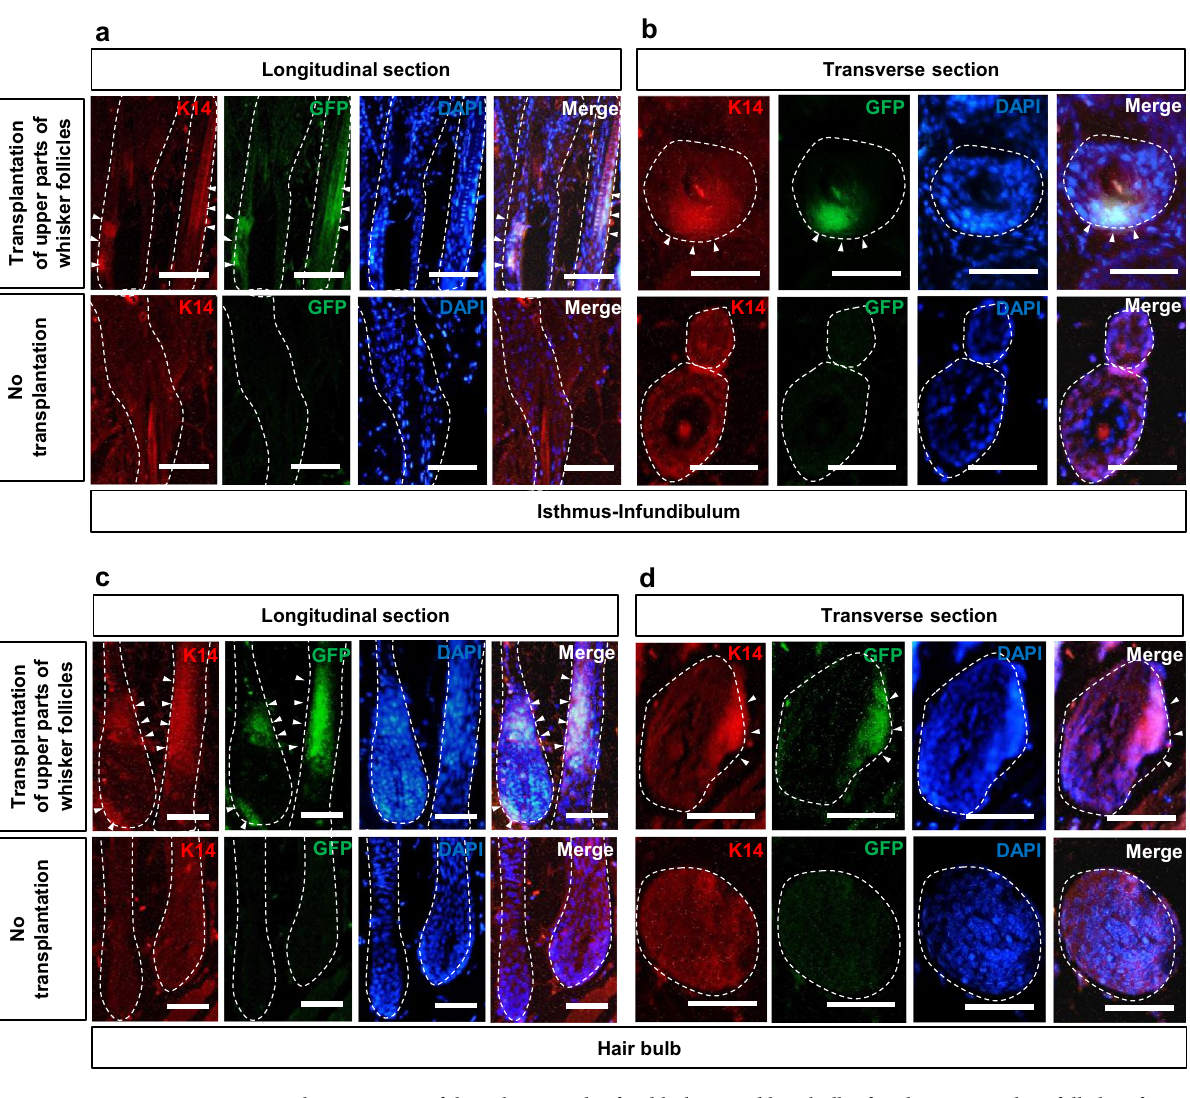
Figure 4. Characteristics of the isthmus and infundibulum, and hair bulb of nude-mouse pelage follicles after transplantation of the upper part of whisker follicles from ND-GFP mice. ( a ) Longitudinal section of a nude- mice pelage follicle from isthmus to infundibulum in the mice transplanted with upper part of whisker follicles from ND-GFP mice or non-transplanted control mice. Scale bar = 50 µm. ( b ) Transverse section of a nude-mice pelage follicle at the isthmus in the transplanted mice or non-transplanted control mice. Scale bar = 25 µm. ( c ) Longitudinal section of a nude-mice pelage follicle at the hair bulb in the transplanted mice or non-transplanted control mice. Scale bar = 50 µm. ( d ) Transverse section of nude-mice pelage follicle at the hair bulb in the transplanted mice or non-transplanted control mice. Scale bar = 25 µm. White dotted lines outline the pelage follicle. White arrowheads indicate the HAP stem cells which jumped to the pelage